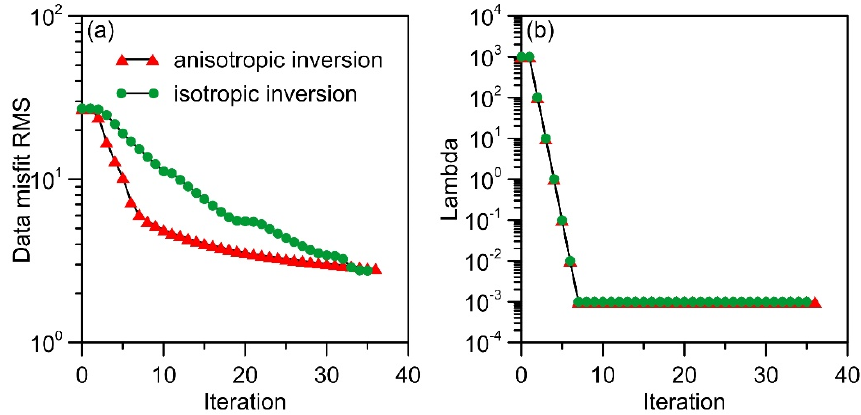
Figure 15. Plots of inversion parameters for the inversion of survey data acquired from Musgraves, South Australia. ( a ) Data misfit RMS; ( b ) regularization parameter λ .